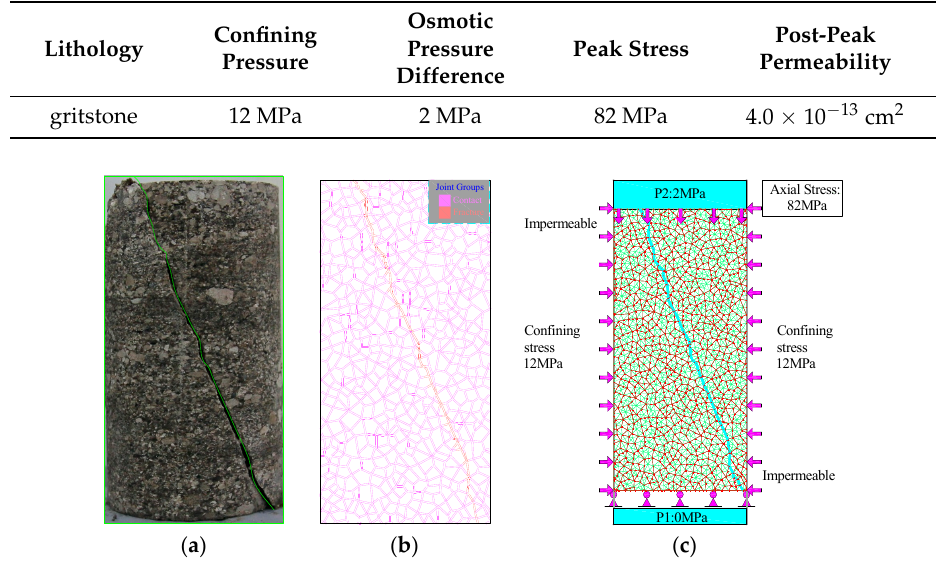
Figure 8. Post-peak fracture rock sample and reconstruction model. ( a ) the outline of the crack ( b ) Joint groups ( c ) Seepage calculation model.